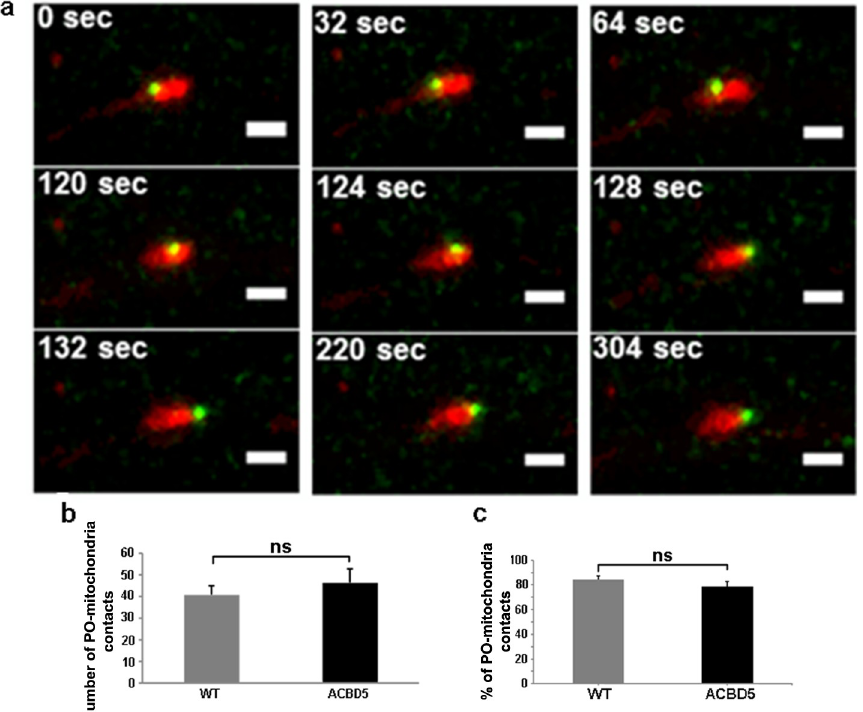
Fig 5. Close contacts of POs and mitochondria in live confocal images. (a) Time lapse series of a PO “surfing” on a mitochondrion over a period of 5 min (scale bar: 2 μ m, maximum intensity projections). (b, c) Absolute numbers and proportion of POs juxtaposed to mitochondria in the neurite area of each hippocampal neuron.